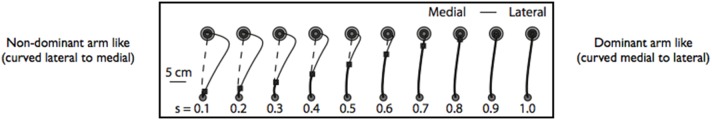
Simulated trajectories for different switch times between predictive and impedance controller. Dashed line shows pure optimal predictive controller. Early switch times (Left) are controlled almost entirely by the impedance control algorithm, while late switch times (Right) are almost entirely controlled through optimal predictive control (form Yadav and Sainburg, 2014).